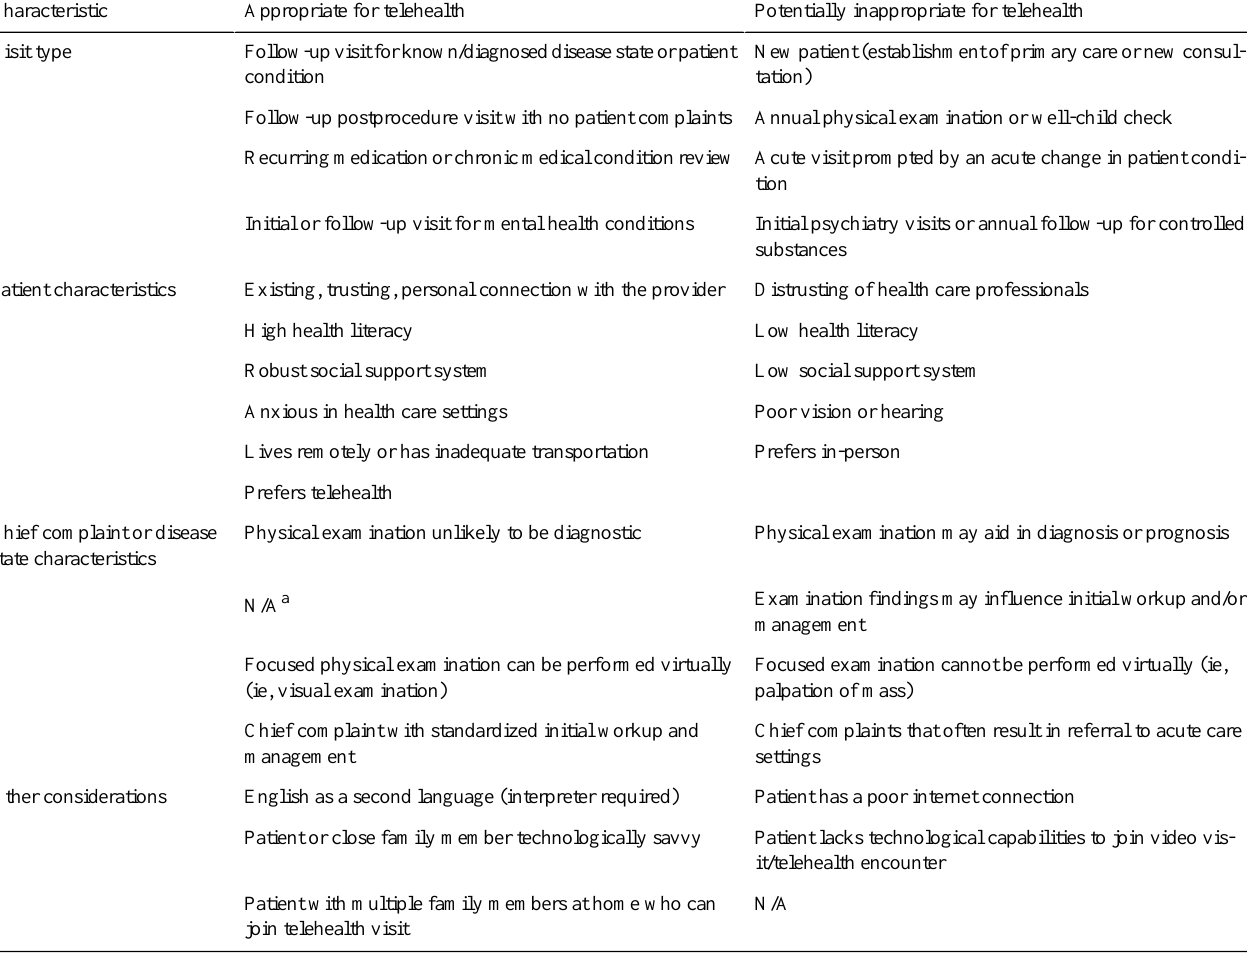
Table 1. Characteristics to consider for determining the appropriateness of